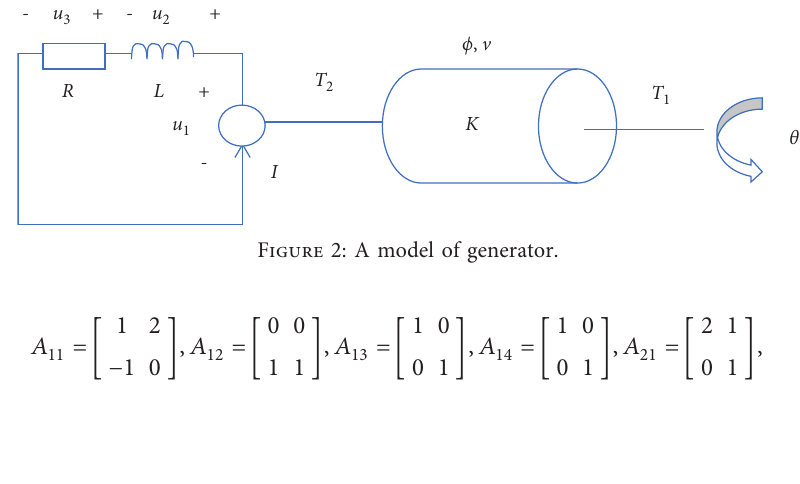
Figure 1: The comparisons between the exact solution and approximate solution of the test example.